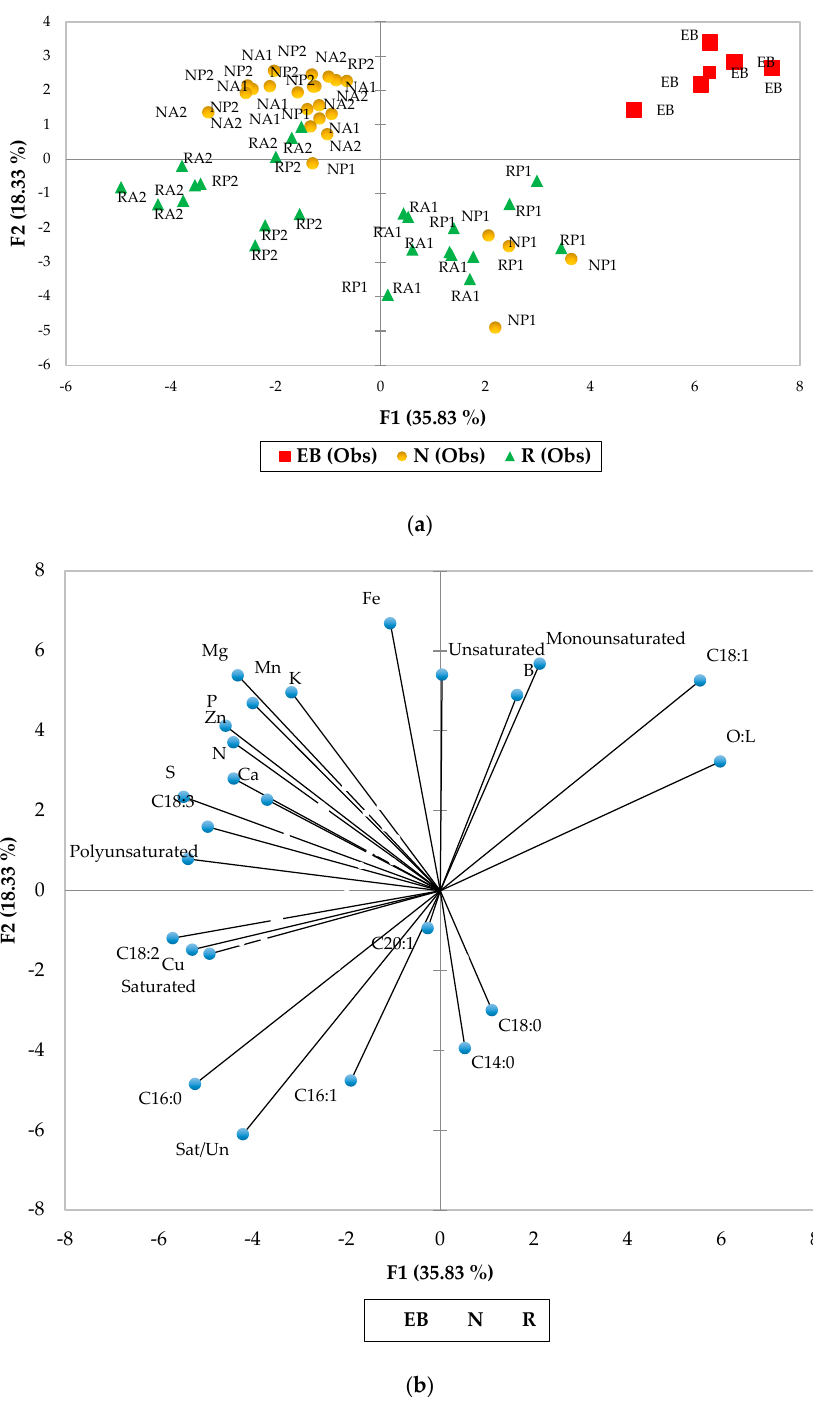
Figure 6. Principal component analysis (PCA) results of the mineral and FAME contents grouped by the samples: ( a ) Score plot; ( b ) Loading plots. Blue dots: active variables. Orchards: EB, N, and R. A: Nutrient management based on the Balanced Indices of Kenworthy (BIK). P: Nutrient management of the farmer. 1. Harvest from the intermediate flowering period. 2. Harvest from the main flowering period. Sat/Un (saturated and unsaturated relationship); C14:0 (myristic acid); C16:0 (palmitic acid), C16:1 (palmitoleic acid), C18:0 (stearic acid); C18:1 (oleic acid), C18:2 (linoleic acid), C18:3 (linolenic acid). C20:1 (arachidic acid), O:I (oleic and linoleic fa tt y acids relationship).